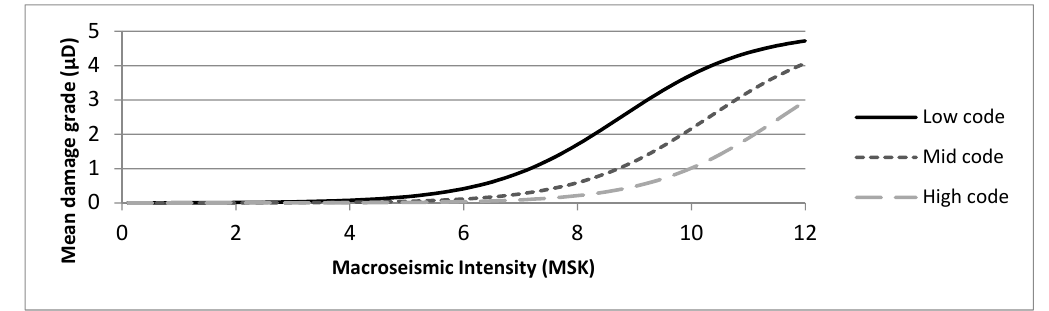
Figure 8. Mean damage grade for the considered building codes.